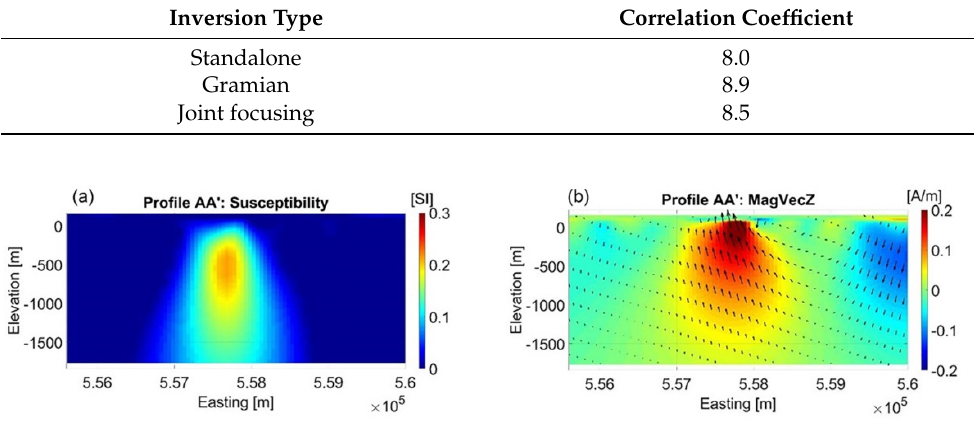
Table 1. Correlation coefficient for different inversion scenarios.